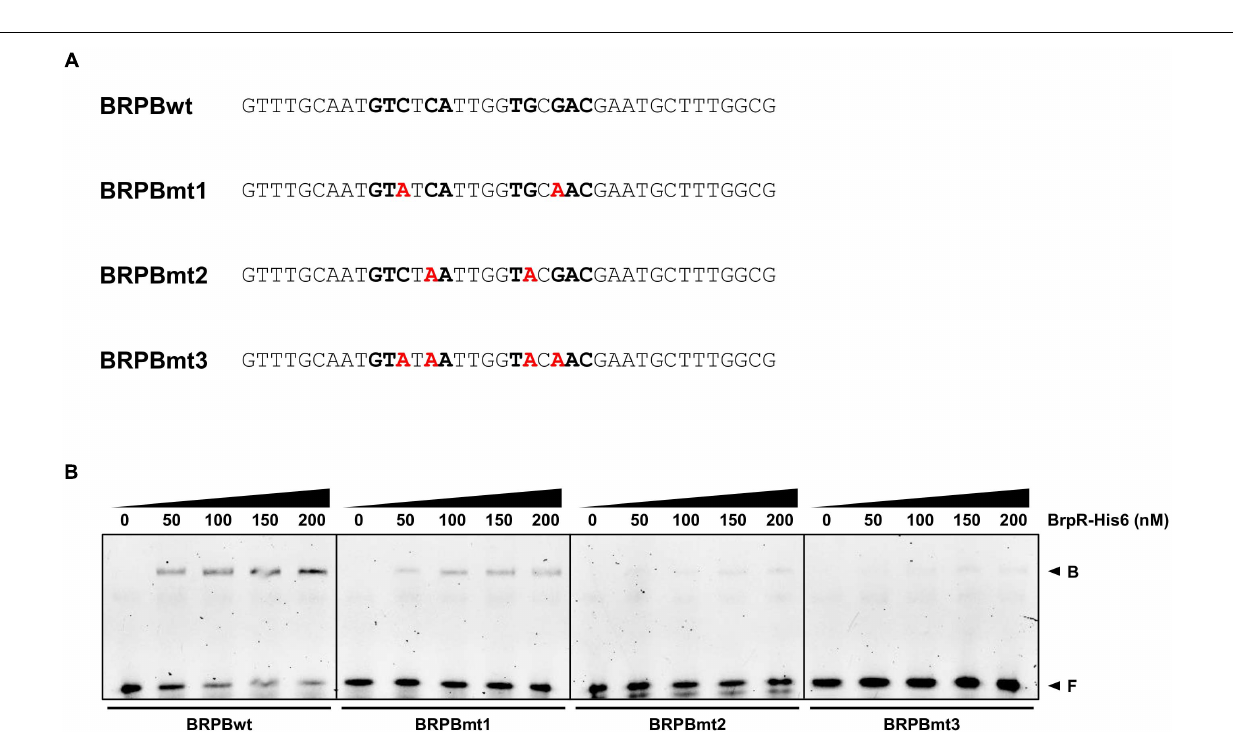
FIGURE 12 | Effects of the mutation in the palindromic sequence on the BrpR-His6 binding. (A) The sequences of 38-bp DNA oligonucleotides which contain the wild-type (BRPBwt) or mutated (BRPBmt1, BRPBmt2, and BRPBmt3) palindromic sequences for the BrpR-His6 binding are shown. The palindromic sequences are shown in bold, and the mutated bases are shown in red. (B) The 6-FAM-labeled DNA oligonucleotides were incubated with increasing amounts of BrpR-His6 as indicated in the presence of c-di-GMP (50 µ M). B, bound DNA; F, free